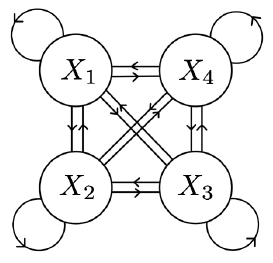
Figure 1 . General quiver diagram for s = 4